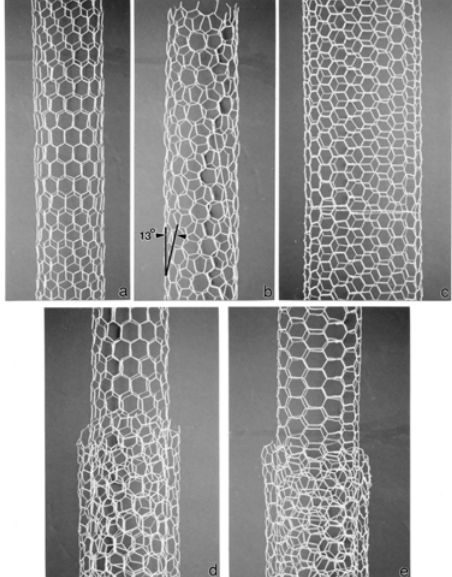
Figure 6: Simple wire models for carbon nanotube types. (a) Zig-zag tube; θ = 0º. (b) Chiral tube; θ = 13º. (c) Armchair tube; θ = 30º. (d) Chiral tube growing over zig- zag tube. (e) Chiral tube growing over armchair